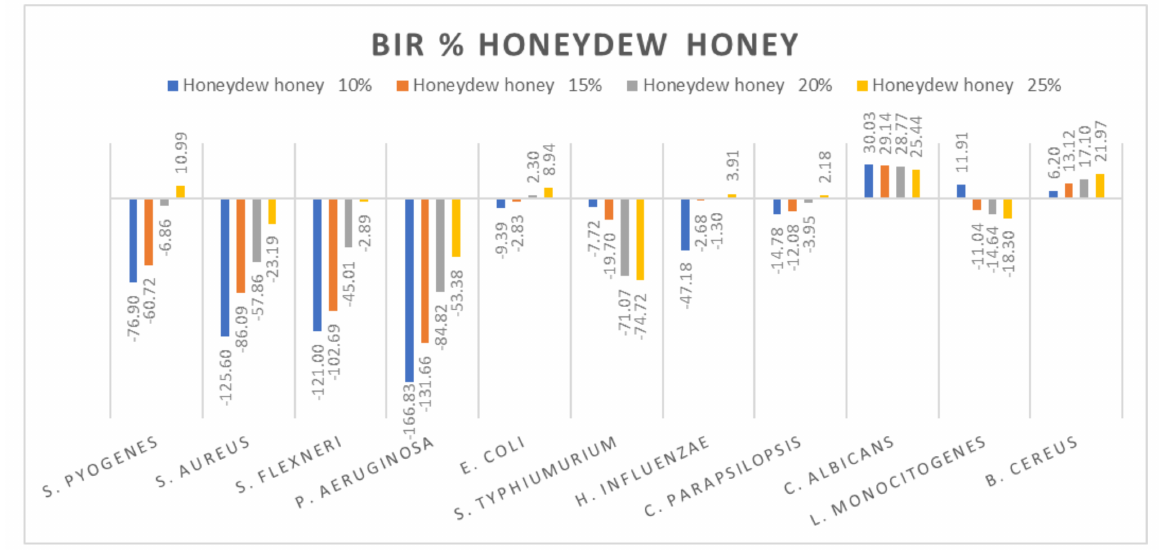
Figure 9. Honeydew antimicrobial activity (expressed as BIR%/MIR%) on ATCC strains. Concerning the four oilseed rape honey concentrations tested (10%, 15%, 20% and 25%), the results presented in Figure 10 show the best antimicrobial effect recorded against E. coli , S. typhimurium , and B. cereus with values reaching 24.05%. The effect was contrary to the concentration increase, with values ranging from − 76.9% to − 137.42% for S. pyogenes , − 40.41% to − 121.45% for P. aeruginosa , 37.58% to − 11.2% for C. albicans and 14.11% down to − 18.63% for B. cereus . S. aureus and S. flexneri proved a positive strain-boosting effect, with negative values that decreased alongside the concentration increase, showing small inhibitory activity due to insufficient